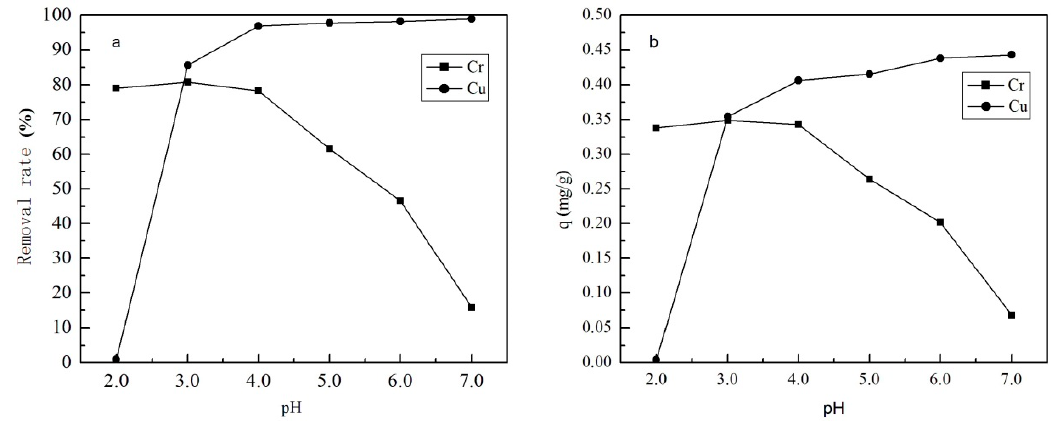
Figure 1. Effect of pH on the removal rate ( a ) and adsorption capacity ( b